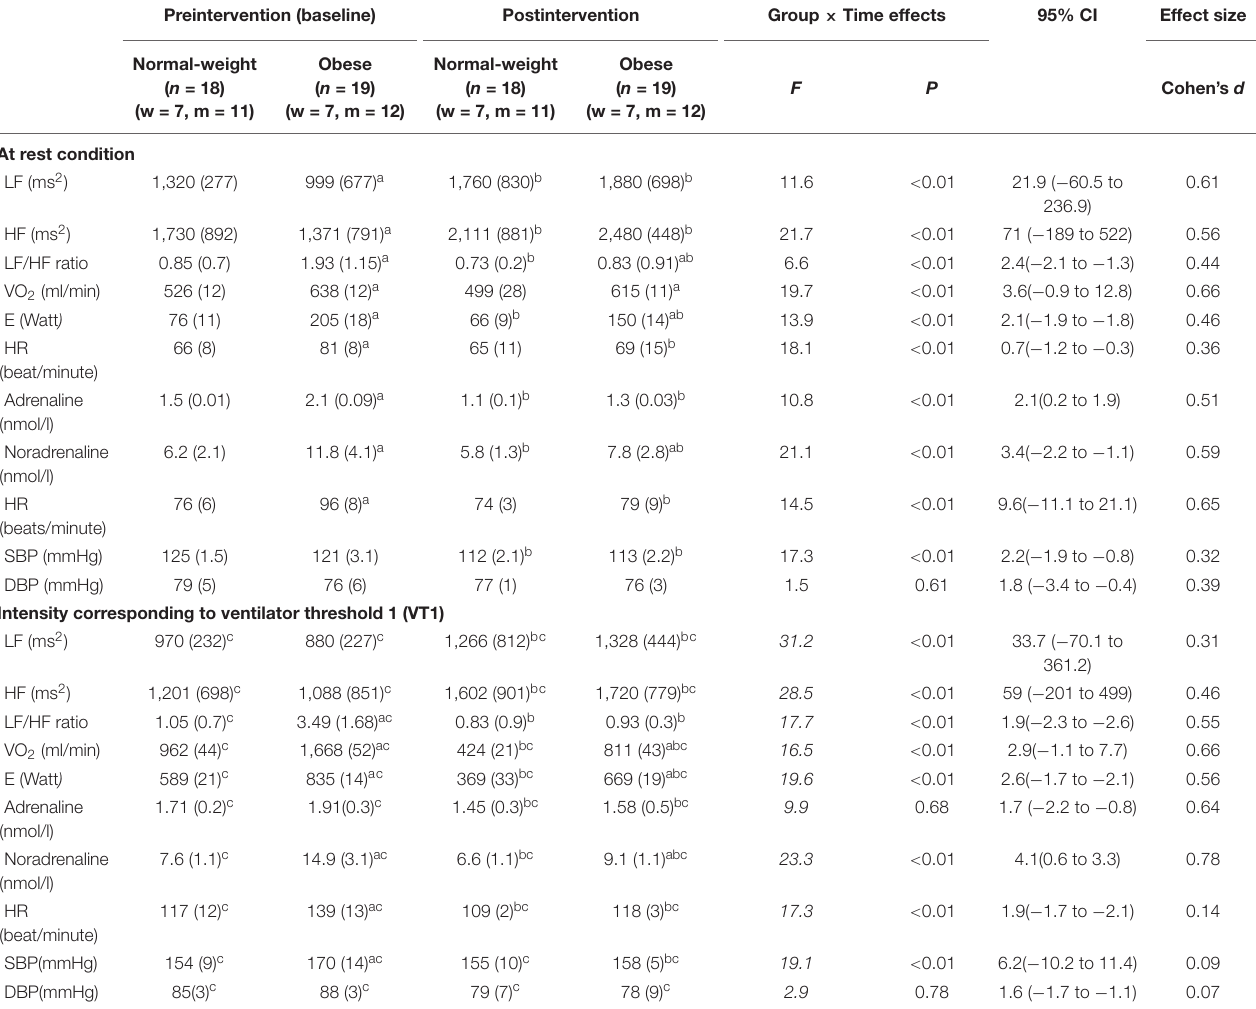
TABLE 2 | Frequency domain marker, fitness and hormonal parameters measured at baseline and after 6-week supramaximal exercise training. Preintervention (baseline) Postintervention Group × Time effects 95% CI Effect